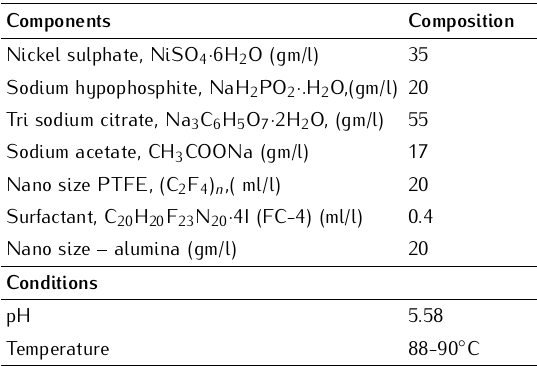
Table 1. Composition and Operating Conditions of Electroless bath for NiPPA nano-dispersion coating.